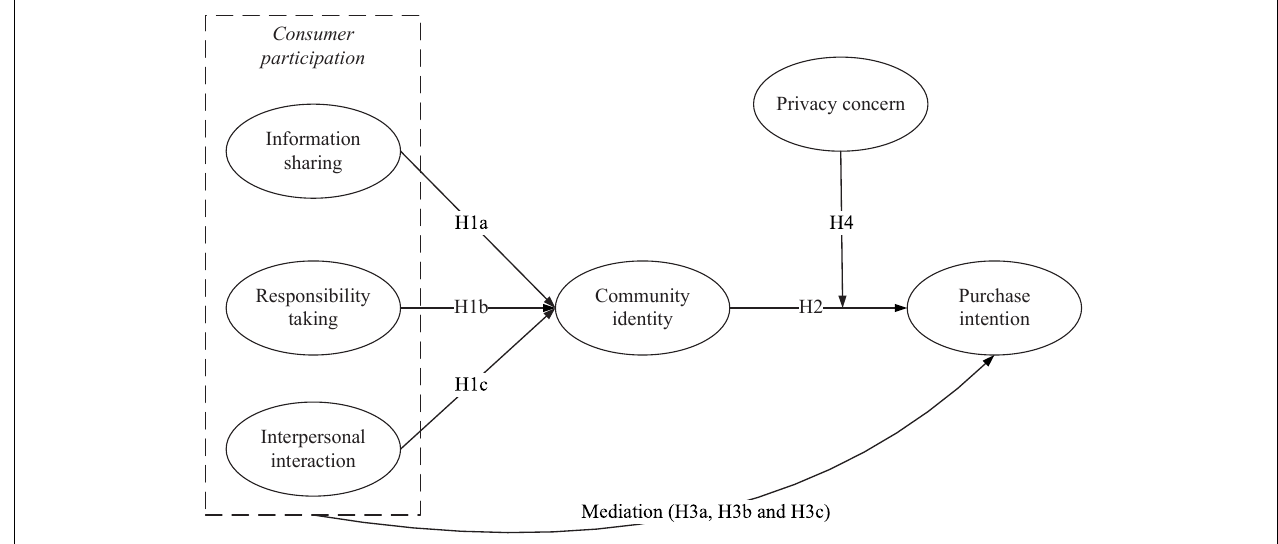
FIGURE 1 | Theoretical